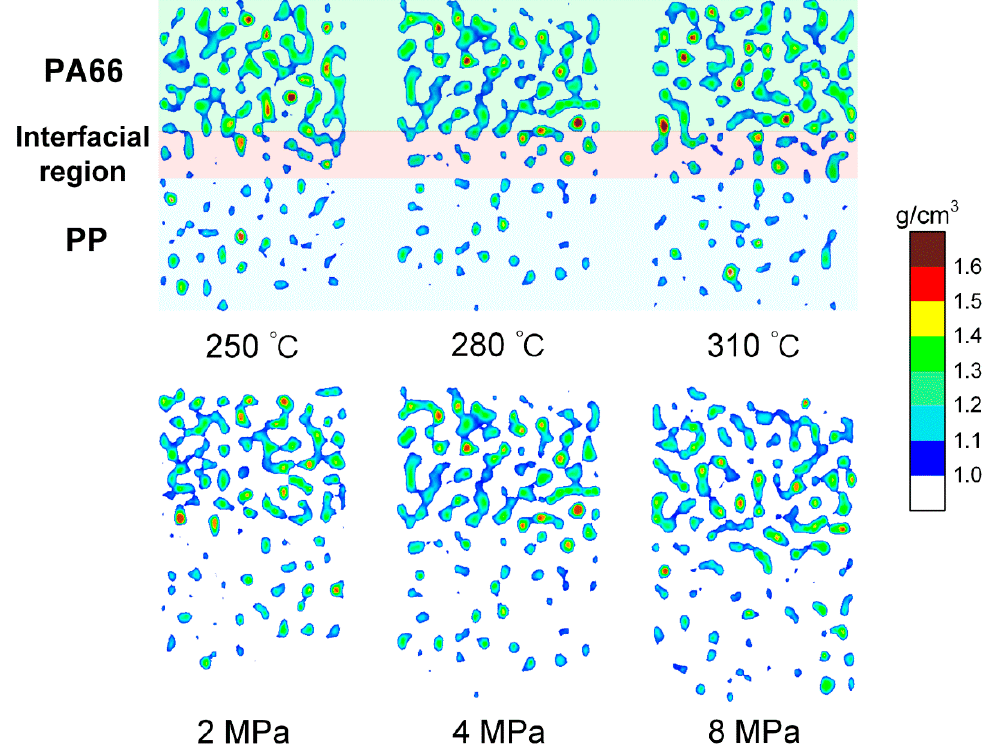
Figure 4. Nephogram of the high-density concentration of composite system along the z direction at 300 ps under different processing parameters.